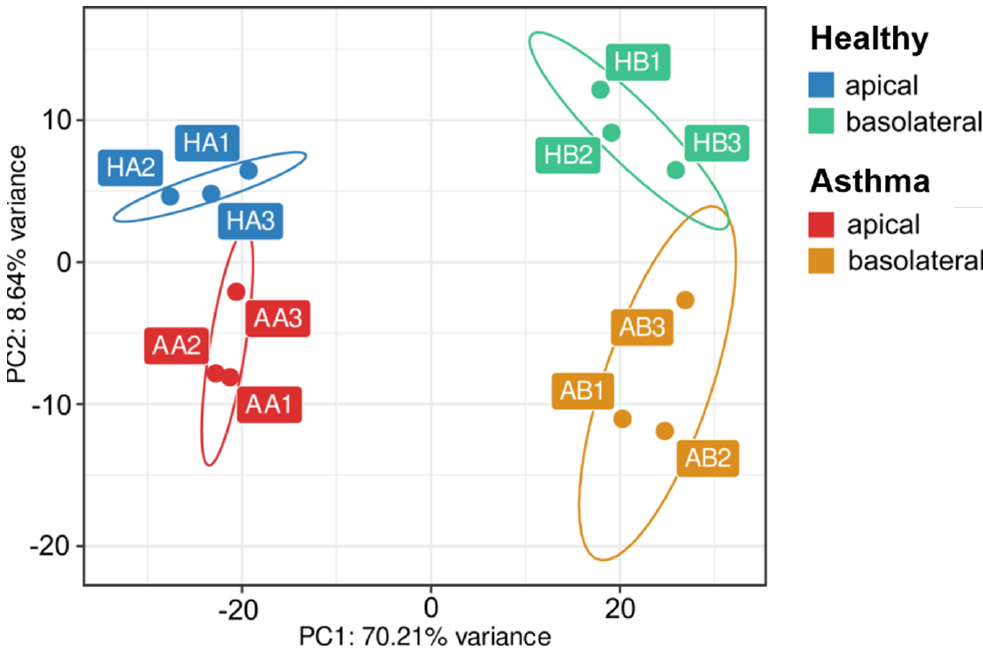
Figure 4. PCA plot depicting the clustering of 12 EV samples according to their miRNA cargo depending on disease condition and cellular side of EV release. PCA—principal component analysis; EV—extracellular vesicle.